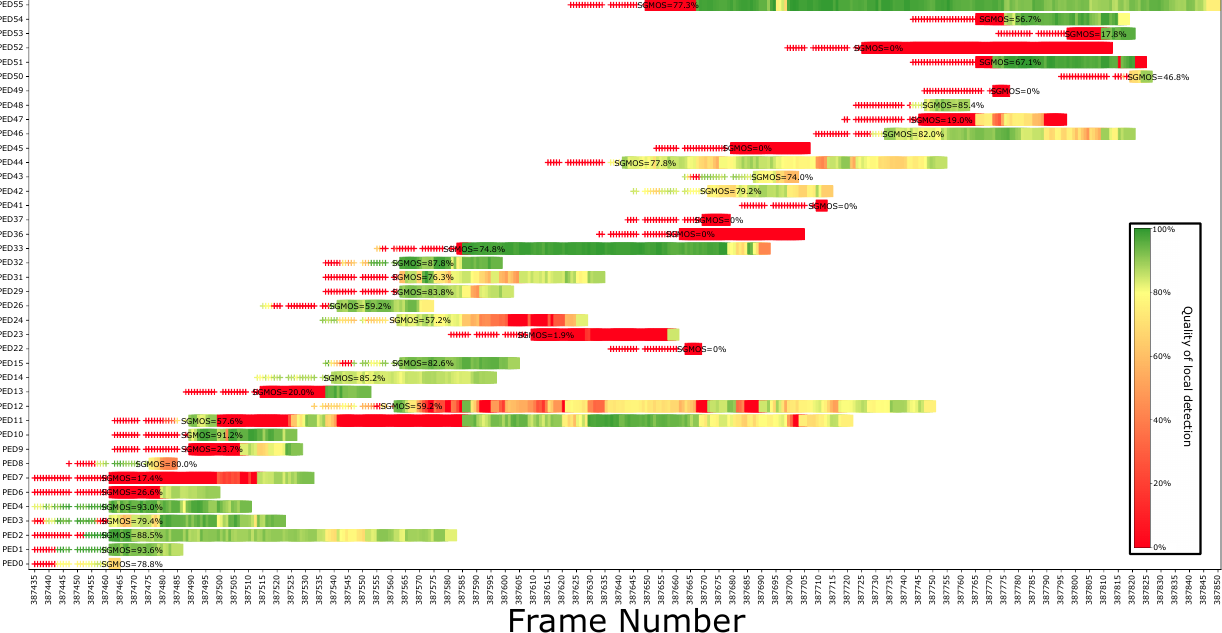
Figure 4. Visualization of results for the event evaluation. Each bar represents the quality for a single object during its appearance in the camera field of view. Crosses mark the state of detection before the Critical Index for a given event. Values of SGMOS for given sequence are on each